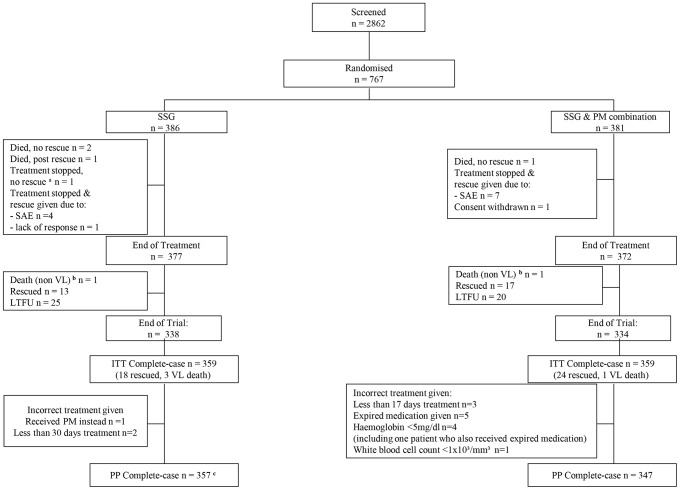
CONSORT Patient Flowchart – SSG vs. SSG&PM.SSG, sodium stibogluconate; PM, paromomycin sulphate; SAE, serious adverse event; LTFU, loss to follow-up; ITT, intention-to-treat; PP, per protocol. Patients included in the SSG (SSG at 20 mg/kg/day for 30 days) vs. SSG & PM combination (SSG at 20 mg/kg/day & PM at 15 mg/kg/day for 17 days) arms; a patient was diagnosed with tuberculosis and was removed from the study before the end of treatment; b patient died from non-VL causes; c patient with deviation also had a missing outcome value and was already excluded from the ITT analysis.